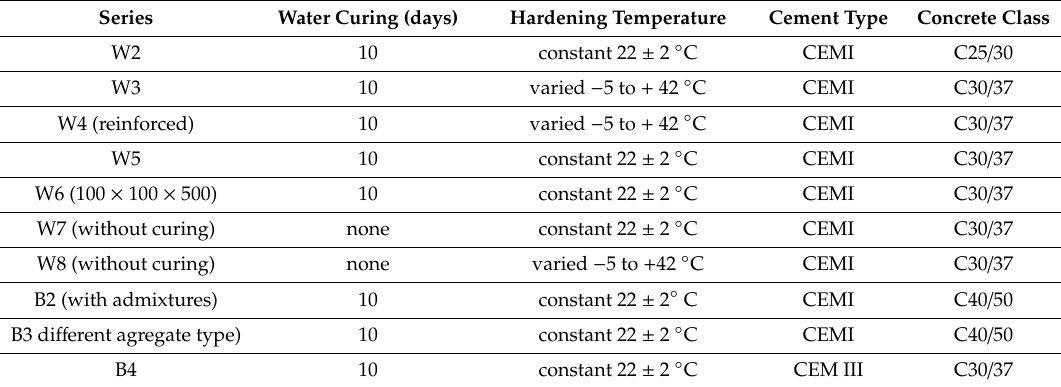
Table 3. Sample parameters and testing